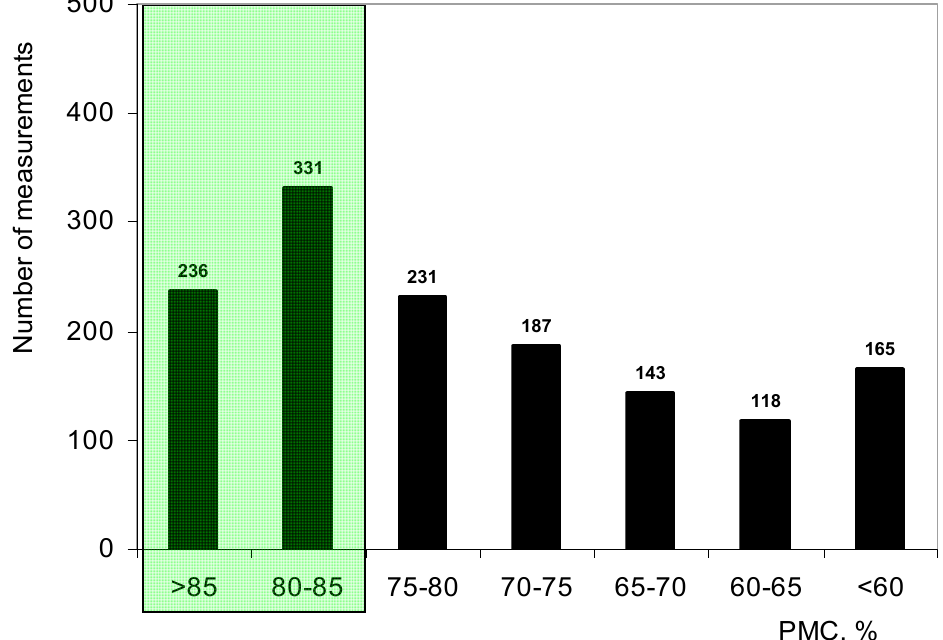
Figure 5. Distribution of the number of measurements performed in each pasture moisture content (PMC) class considered in the calibration phase.